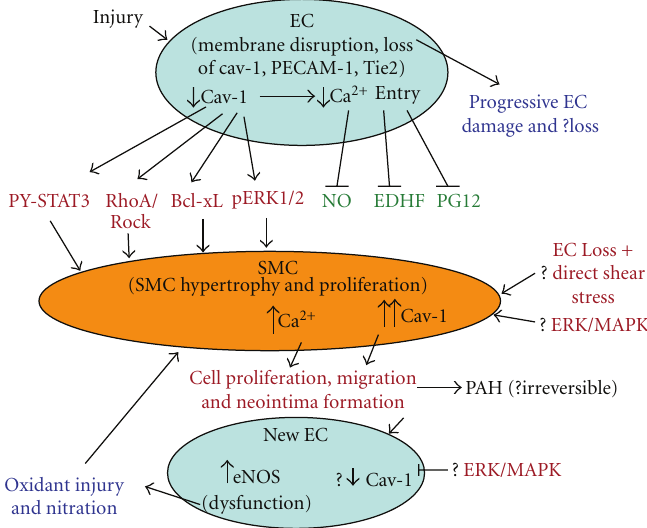
Figure 2: This figure depicts the proposed model of PH (#1). Injury to EC results in progressive loss of endothelial caveolin-1, loss of vasodilators, and the activation of proliferative and anti-apoptotic pathways leading to PH. EC disruption is progressive resulting in further loss of multiple proteins and possibly the loss of EC. Extensive damage/loss of EC exposes SMC to direct shear stress leading to enhanced expression of caveolin-1 which participates in further cell proliferation and cell migration resulting in neointima formation. Newly formed EC in neointima express increased eNOS; possibly low caveolin-1 expression in these cells may in part be responsible for the observed dysfunctional eNOS. The resulting oxidant/nitration injury further influences PH